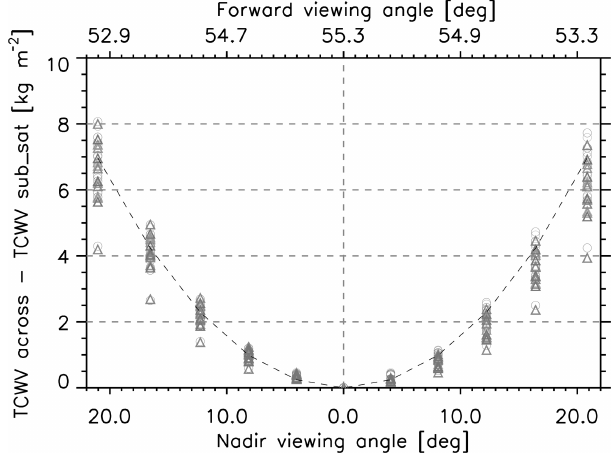
Figure 1. Differences between TCWV calculated from across pix- els and TCWV calculated from the subsatellite track as a function of across-track position calculated for different atmospheric scenarios and for AATSR (symbols). Grey dashed line corresponds to AIR- WAVEv1 parameterisation.